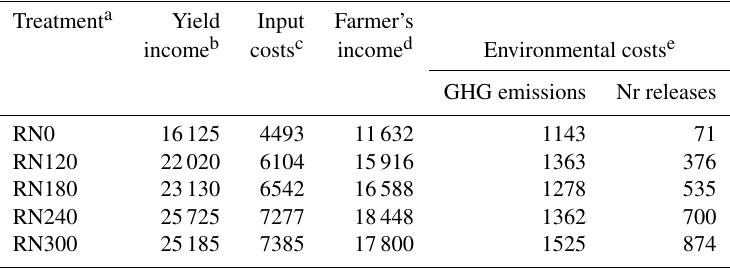
Table 6. The economic indicators (two-season average) for rice production of the growing seasons from 2013 to 2014 in the Taihu Lake region (unit: CNYha − 1 )